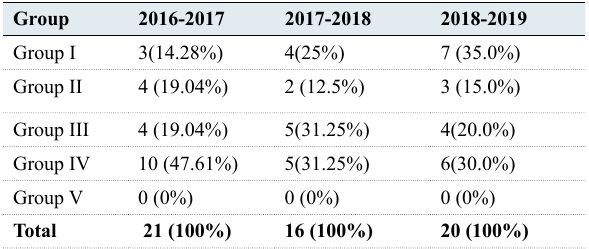
Table 3 Comparison of Perinatal deaths by Wigglesworth’s classification over three years